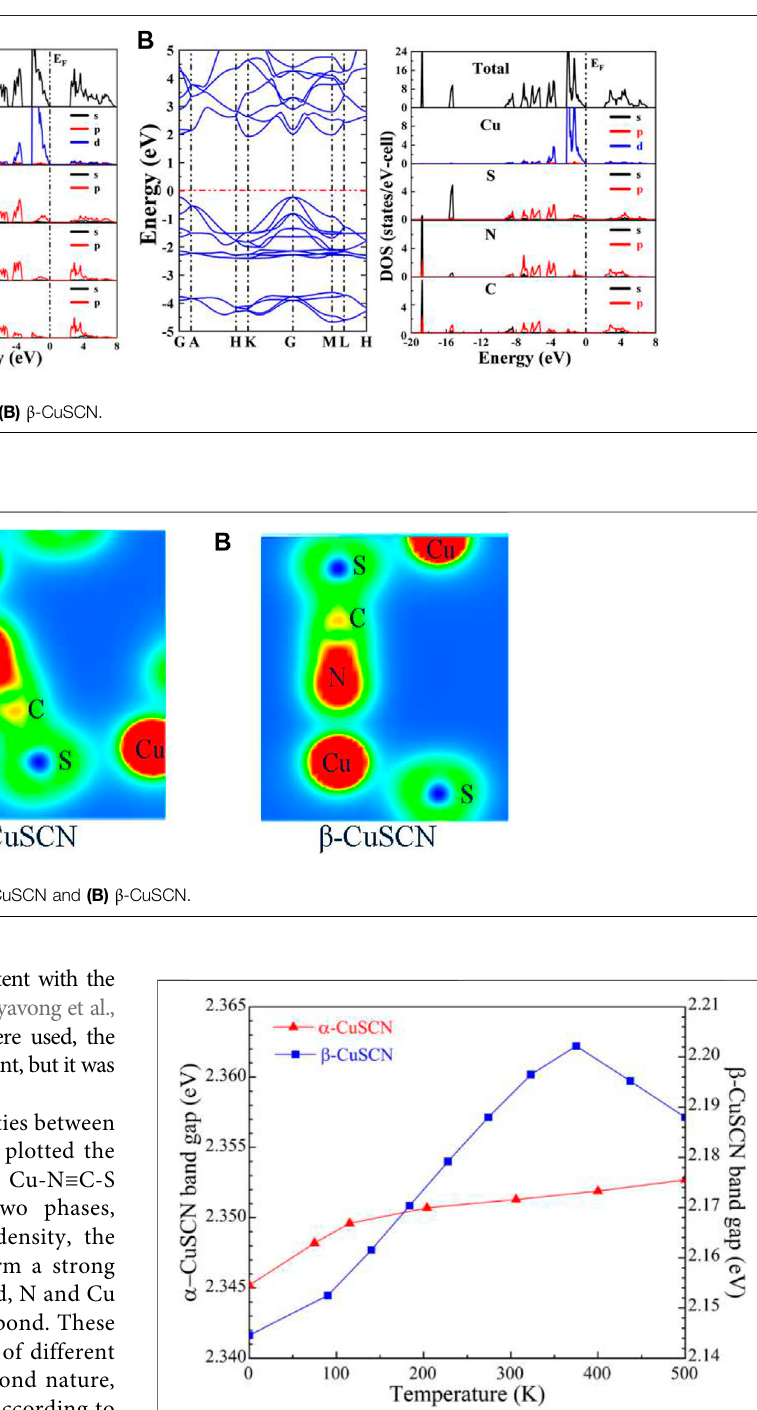
Frontiers in Materials |